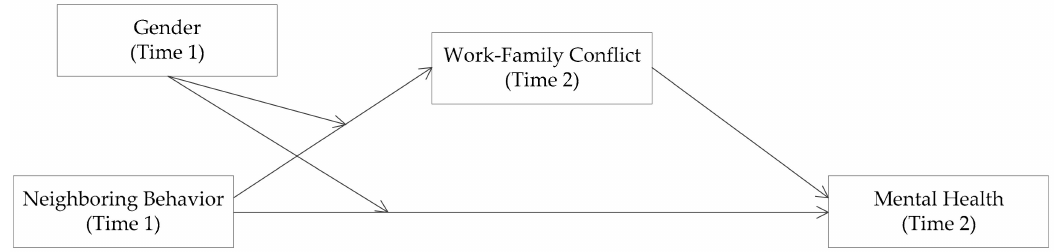
Figure 1. Conceptual